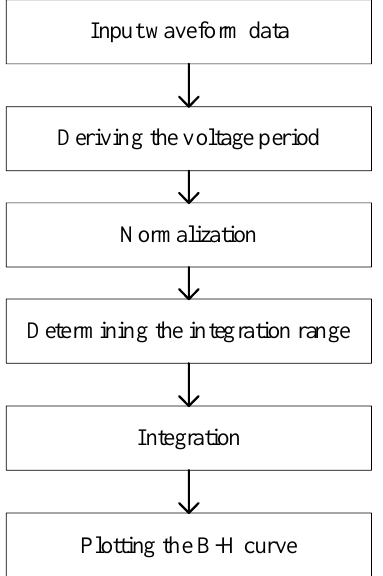
Figure 9. Flowchart of digital integration.